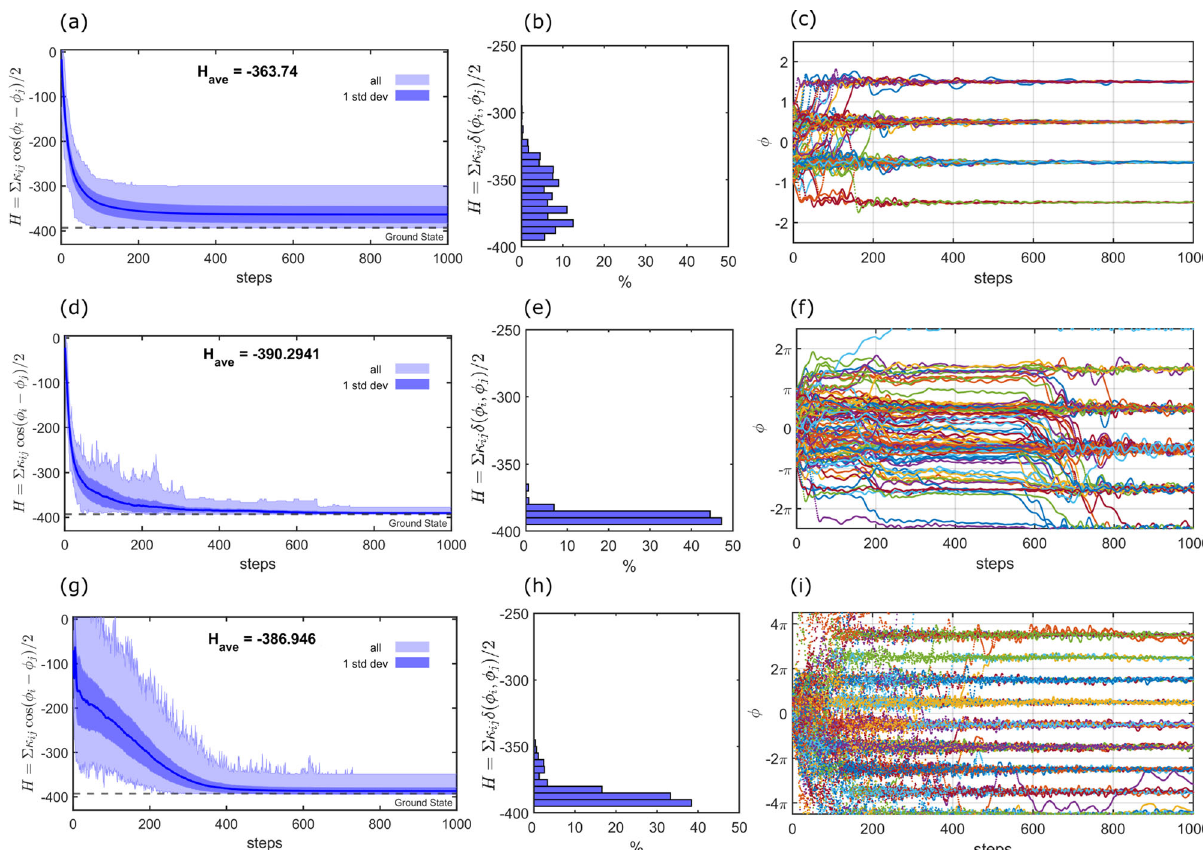
Fig. 3 Constant gain, adiabatic gain, and chaotic annealing methods for solving an Ising problem instance. The optimization results for the Ising problem on the “ g05 100.6 ” graph with 100 nodes for constant gain ( a – c ), adiabatic gain ( d – f ), and chaotic annealing ( g – i ). The fi rst column depicts the time-evolution (cid:2) ϕ Þ = 2 (where κ ϕ ’ s steady-state phase) for of the Hamiltonian H ¼ ∑ κ cos ð ϕ ij is the coupling strength of the i th and j th oscillators and i is the i th oscillator ij i j 1000 random initial conditions. The second column shows the distribution of the Ising energy H = ∑ κ ij δ ( ϕ i , ϕ j )/2 associated with the steady-state solutions. The third column exempli fi es the dynamics of the phases ϕ for one simulation instant. For better visibility, the phase of each oscillator is shown with a different color. In ( a – c ), the gain is set to g = 2.5 and the step size is set to Δ = 0.01. In ( d – f ), the gain is linearly increased from g = 0 to g = 2.5 and the step size is set to Δ = 0.01. In ( g – i ), the gain is set to g = 2.5 and the step size is linearly decreased from Δ = 10×0.01 to Δ = 0.01. In the fi rst column, the transient energy is calculated based on the XY Hamiltonian which transforms to the Ising Hamiltonian as the phases become binary after several iterations. These fi gures show the the minimum-to-maximum range of the energy distribution for all random initializations (light shaded area), the fi rst standard deviation ('1 std dev') of the associated distribution (dark shaded area), and the average energy H ave (blue line) as a function of the iteration